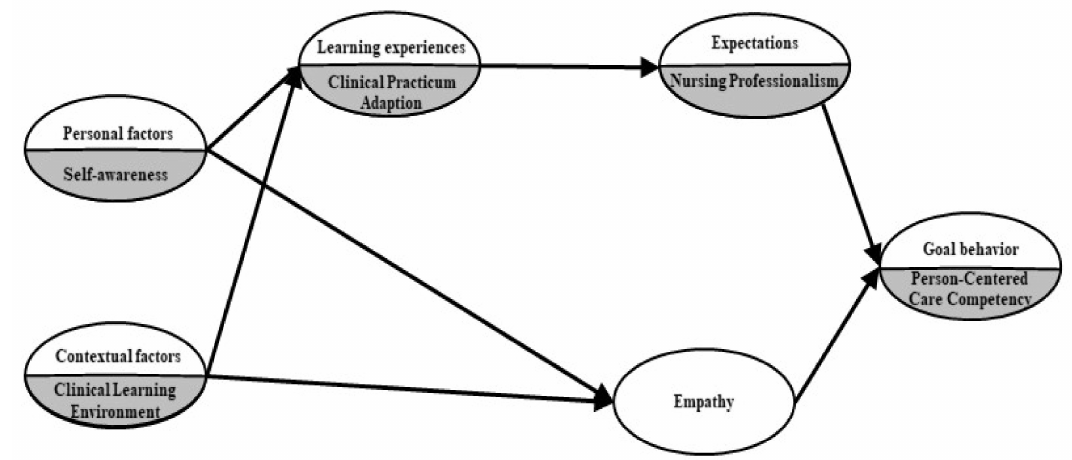
Figure 2. The hypothetical model of this study, based on the social cognitive career theory by Lent, Brown, and Hackett